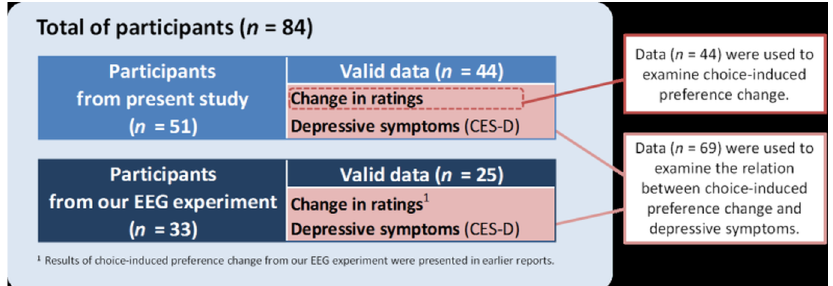
Fig 1. Study participants. We collected84 participants’ data. Of those data, 33 participants’ data related to changein ratings and depressivesymptoms (i.e., CES-D scores) were obtainedfrom earlier EEG experiments conductedusing same paradigmas that used for the present study. Data of two participants were excludedbecause of technicalproblems with a personalcomputer (PC). In addition,data of 13 participants were excludedbecausethe participantsdid not believethe deceptionof the blind choice task. Results related to choice-induced preferencechangefrom our EEG experiment were presented in our previous paper [56]. Therefore, we used the data after excludingour EEG experimentdata obtainedwhen ascertaining whetherchoice-induced preferencechangewas observed. We conductedcorrelationanalysis betweenthe changeof preferenceratings and CES-D for the sample size of n =